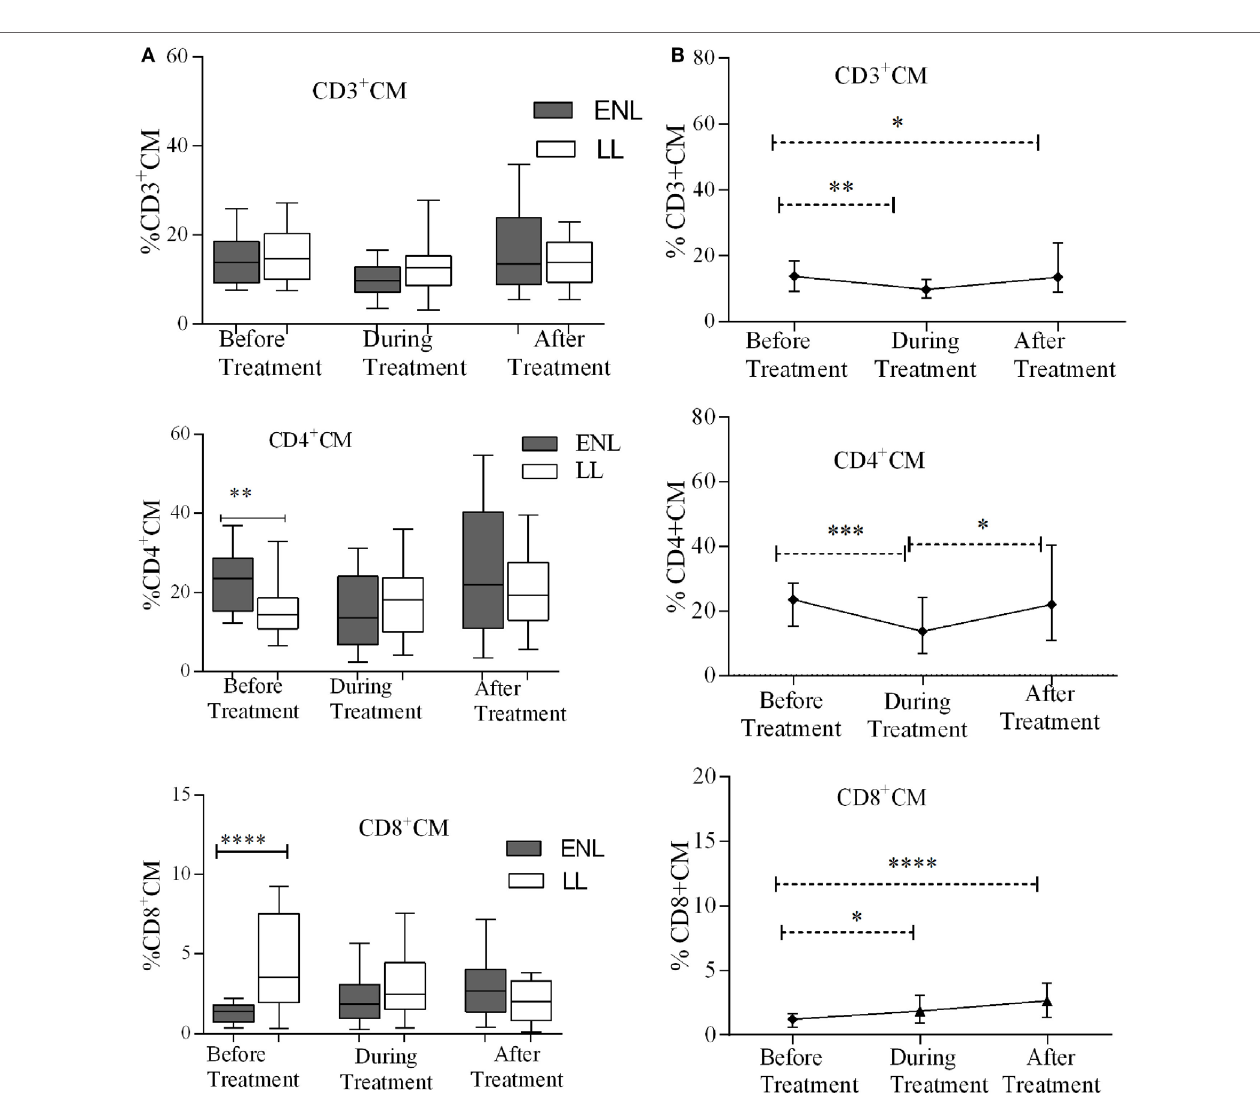
FigUre 5 | Median percentage of CD3 + , CD4 + , and CD8 + central memory T-cells: (a) in patients with erythema nodosum leprosum (ENL) and lepromatous leprosy (LL) controls before, during, and after treatment, (B) within ENL patients before, during, and after treatment. * P ≤ 0.05; ** P < 0.005; *** P < 0.001; **** P < 0.0001 . Box and whiskers (A) and error bars (B) show median ± interquartile